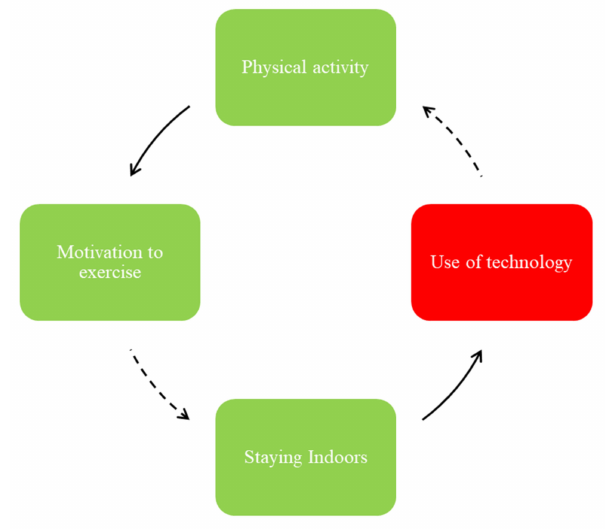
Figure 2. Physical activity and social media use.